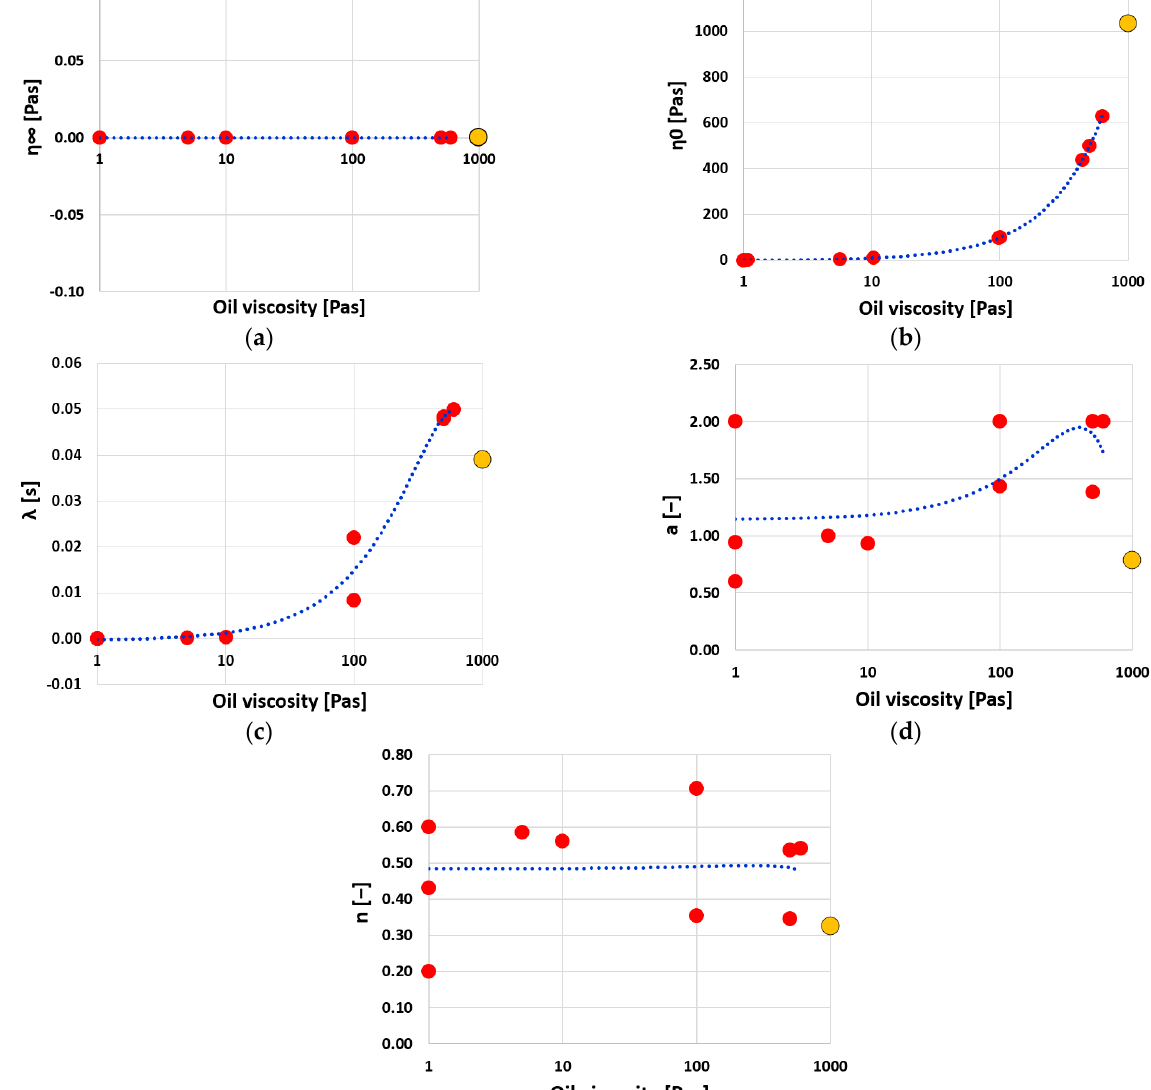
Figure 6. Validation of model parameters (orange dots) with parameter data available in the literature (red dots) with fitted trend line (dotted blue line) for ( a ) infinite-shear dynamic viscosity, ( b ) zero-shear dynamic viscosity, ( c ) relaxation time, ( d ) transition control factor and ( e ) power law index.